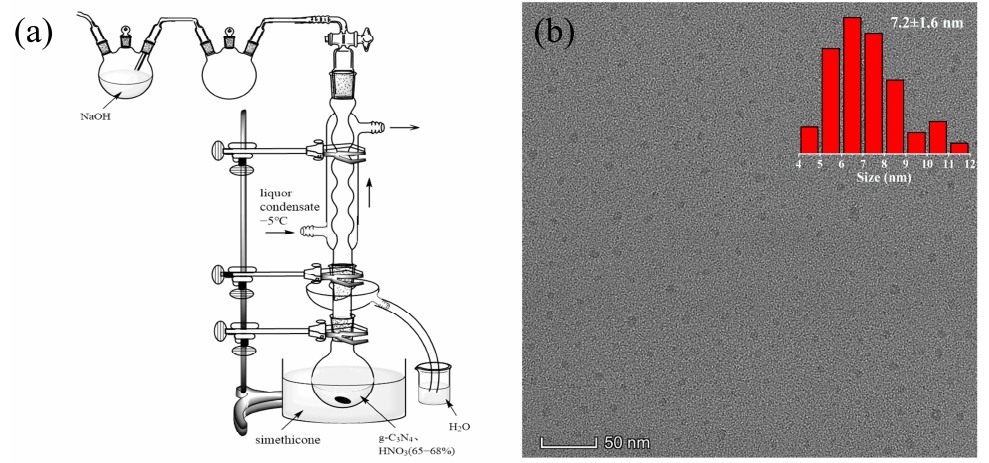
Figure 1. ( a ) Schematic diagram of the self-assembled experimental system. ( b ) TEM image and the particle size map of g-C 3 N 4 QDs.